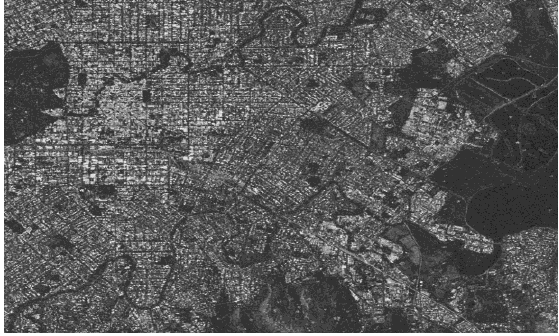
Figure 3. Average coherence image of Christchurch before the earthquake of 22 February 2011